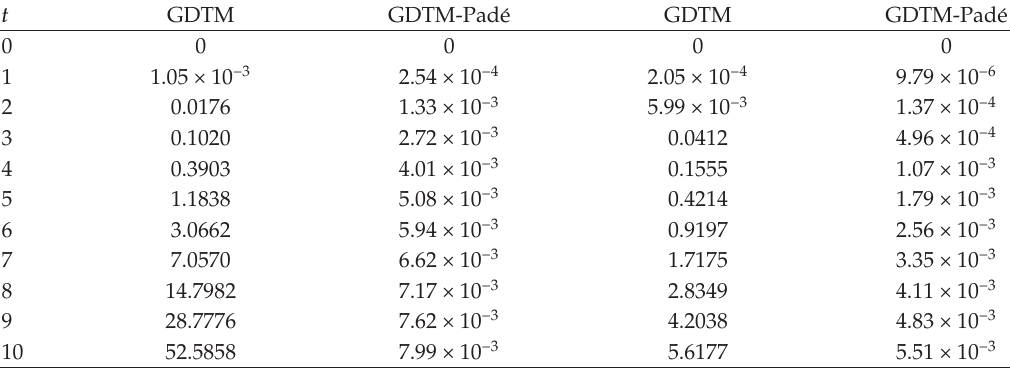
Table 2: Comparisons of the absolute errors between the GDTM solutions and GDTM-Pad´e solutions for (cid:4) 1.2 (cid:5) with c (cid:8) − 0 . 5, d (cid:8) − 2 and n (cid:8)